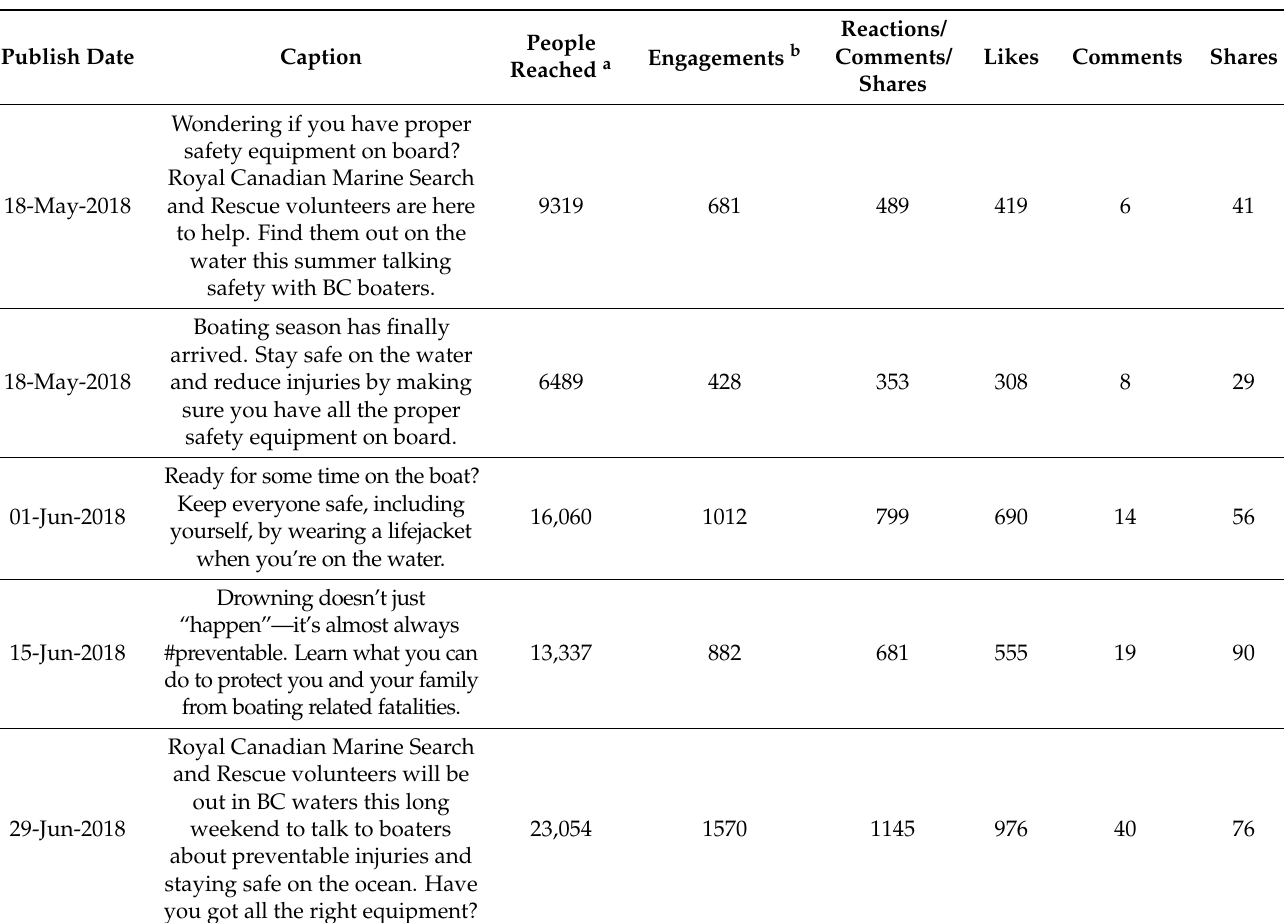
Table 1. Facebook metrics by campaign